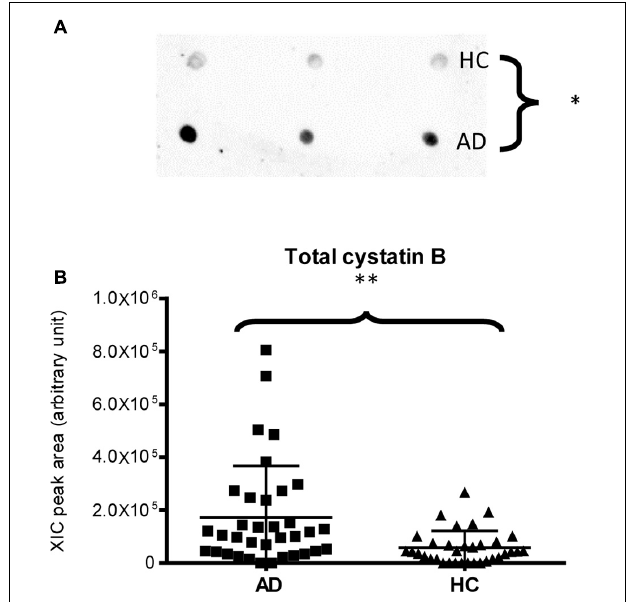
FIGURE 3 | Dot-blotting immunodetection of T β 4 in salivary pools of AD and HC samples (A) and distribution plot of the XIC peak area values of T β 4 measured by HPLC-ESI-MS (B) in each salivary sample from the AD and HC groups ( ∗ , p < 0.05; ∗∗ , p < 0.01).